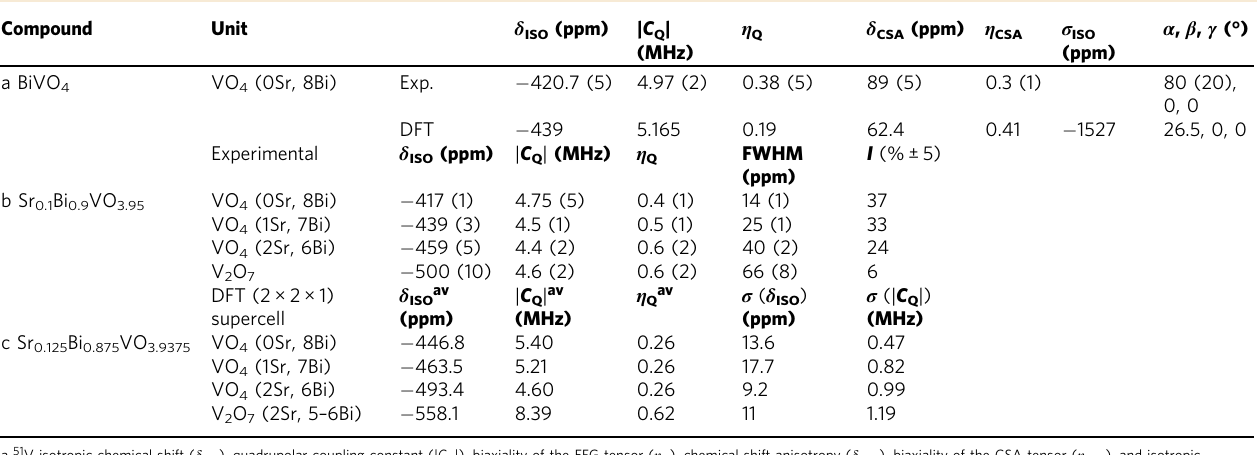
the Euler angles describing the relative orientation of the EFG and CSA tensors. b 51 V δ ISO , | C Q |, η Q , full-width at half-maximum (FWHM), relative intensities and assignment of the four individual contributions in 51 V MAS NMR spectra of Sr 0.1 Bi 0.9 VO 3.95 . c Average 51 V isotropic chemical shift ( δ ISO av ), quadrupolar coupling parameters (| C Q | av ), and biaxiality of the EFG tensor ( η Q av ) and their standard deviations ( σ ) for isolated VO 4 tetrahedra with different number of Sr/Bi atoms surrounding them in their second coordination spheres and V 2 O 7 dimers in Sr 0.125 Bi 0.875 O